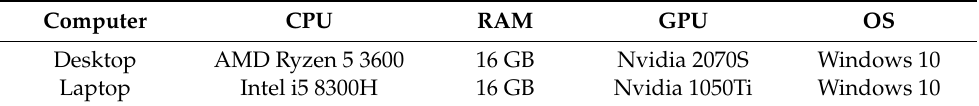
Table 2. Computer Table 2. Computer parameters.